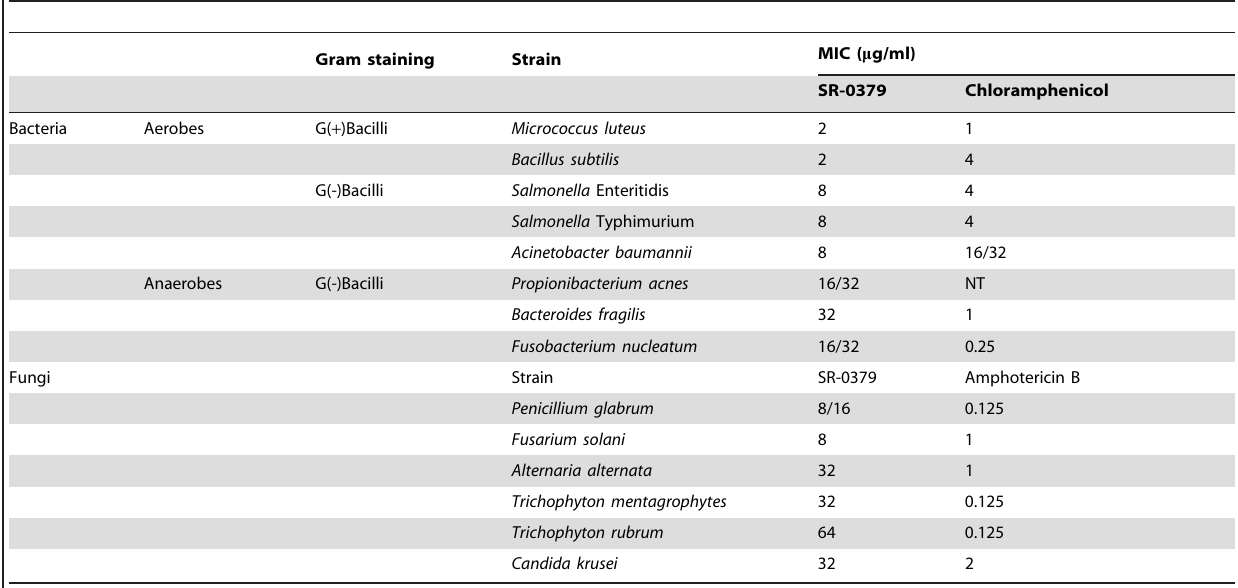
Table 2. In vitro activities of SR-0379 against Gram-positive and Gram-negative bacteria and fungi.